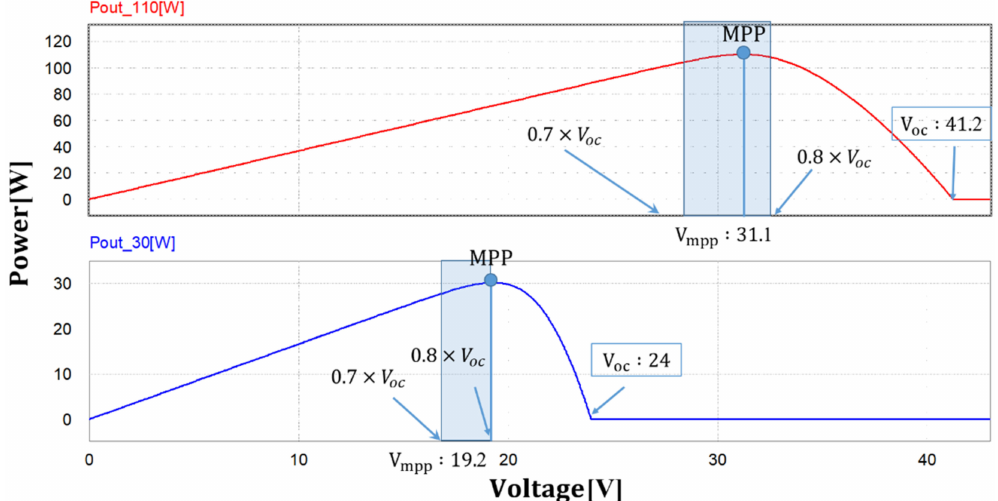
Figure 3. Location of V oc and V mpp